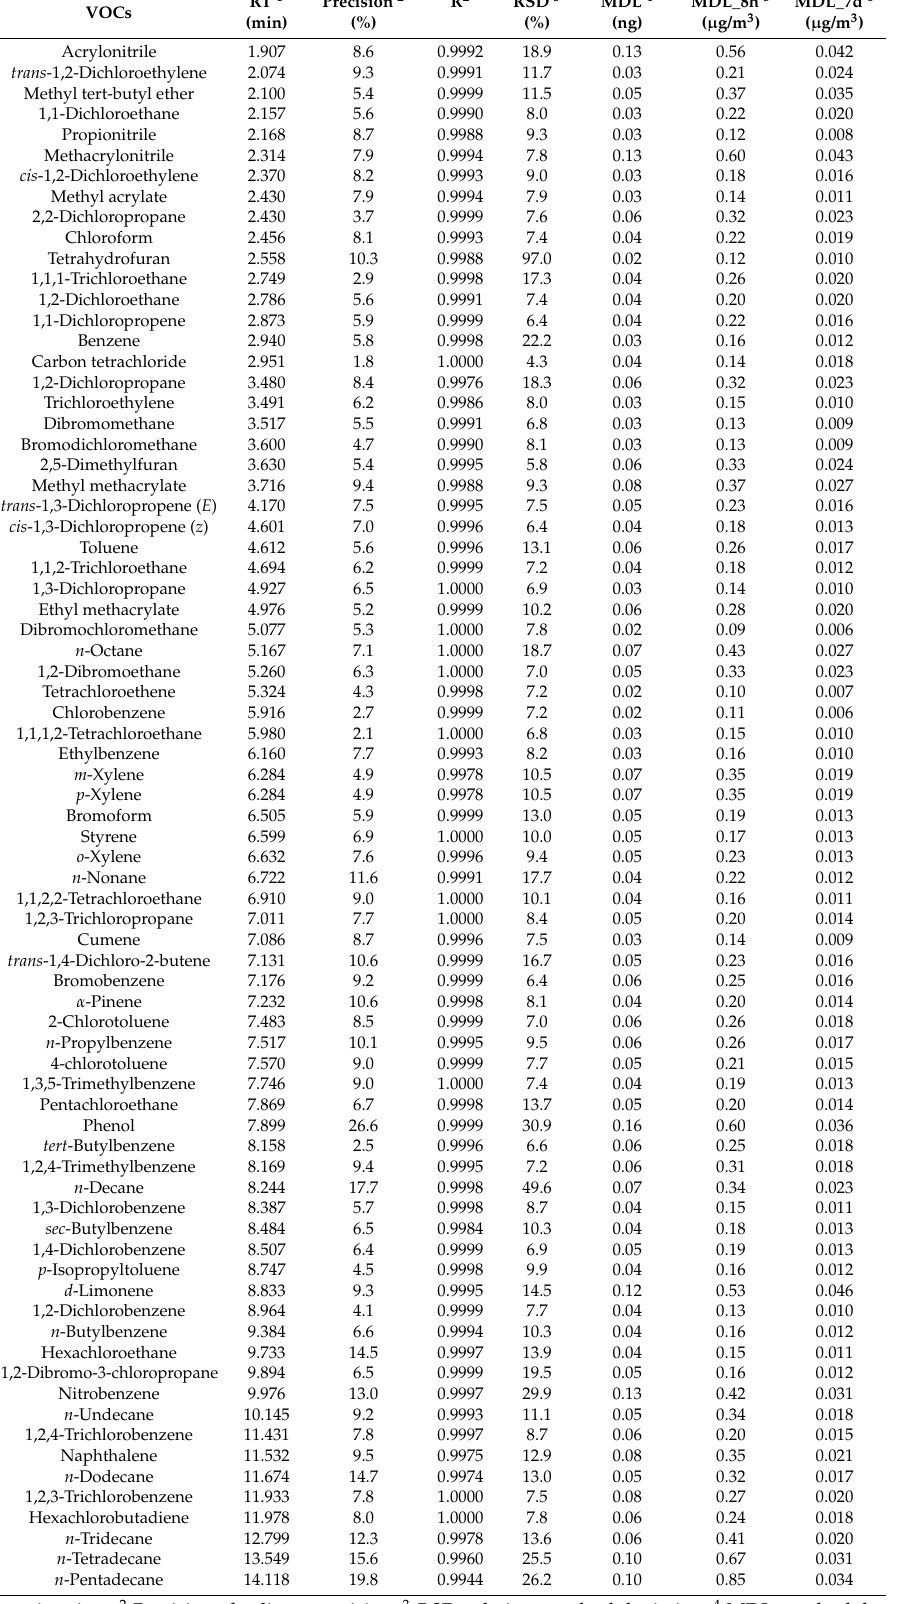
Table 3. Performance of laboratory analysis of automated thermal desorption (ATD)